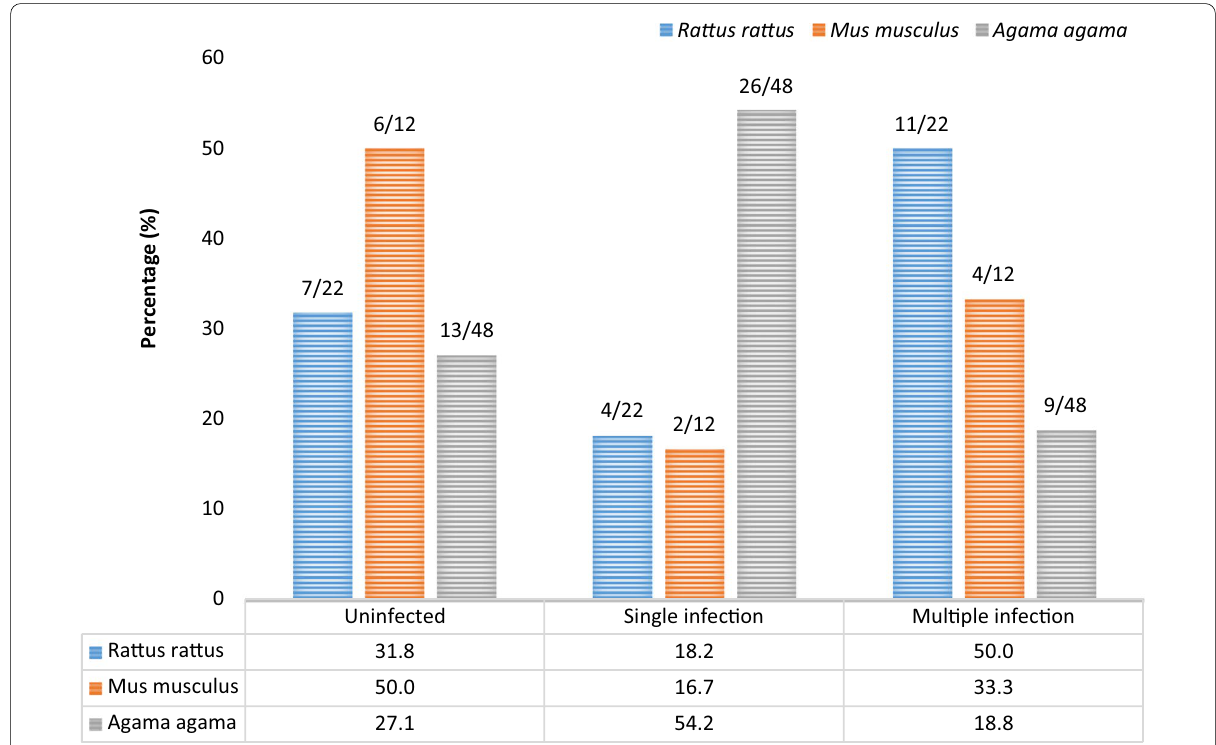
Fig. 1 Level of parasite infection among rodents and lizards